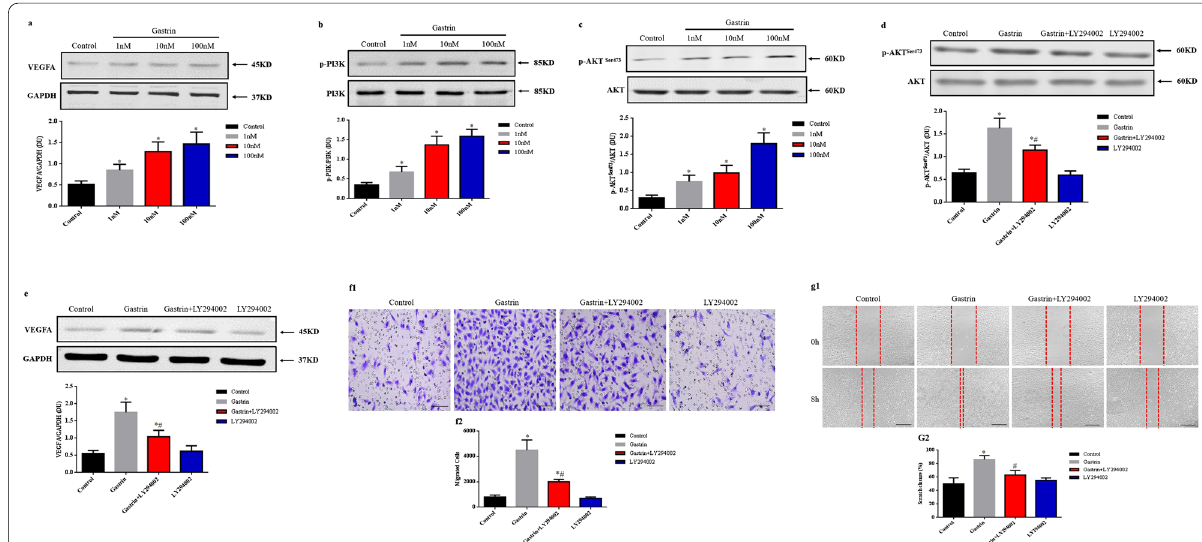
Fig. 5 PI3K/Akt/VEGF signaling pathway is involved in the pro-angiogenic effect of gastrin. Endothelial cells were incubated with gastrin at the indicated concentrations for 24 h. VEGFA ( a ), phospho-PI3K ( b ), and phospho-Akt ( c ) results were normalized by GAPDH, total PI3K, and Akt, respectively. Endothelial cells were treated with gastrin (100 nM, 24 h) in the presence or absence of a PI3K inhibitor, LY294003 (1000 nM). Phospho-Akt ( d ) and VEGFA ( e ) were normalized by GAPDH and total Akt, respectively. n group. f Representative images and quantification of endothelial cell migration detected by transwell migration assay. g , Representative images and quantification of endothelial cell migration detected by scratch wound-healing assay. f and g scale bar # P < 0.05, vs. gastrin-treated group. VEGF, vascular endothelial growth factor; PI3K, phosphatidylinositol 3 kinase; Akt, protein kinase B; DU, density units; p,